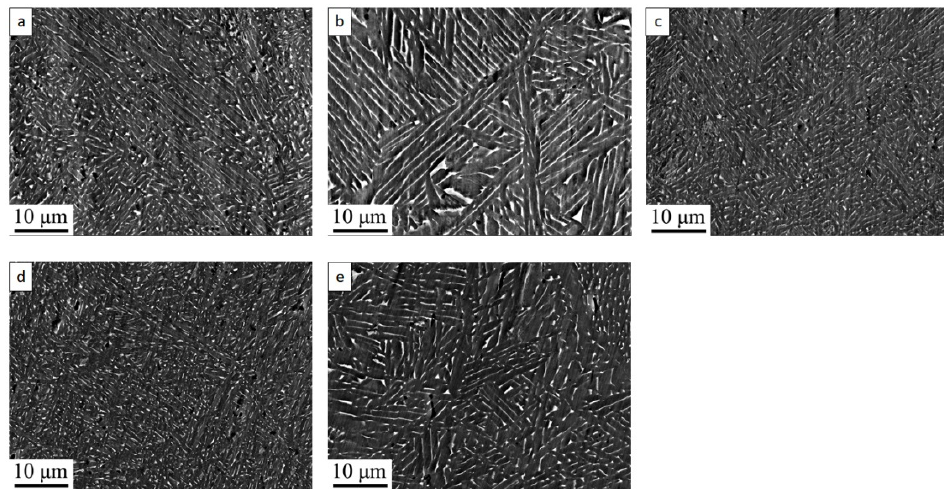
Figure 7. Backscattered electrons (BSE) scanning electron microscopy (SEM) images taken parallel to building direction of samples 2 ( a ), 5 ( b ), 7 ( c ), 8 ( d ), and 9 ( e ). building direction of samples 2 ( a ), 5 ( b ), 7 ( c ), 8 ( d ), and 9 ( e